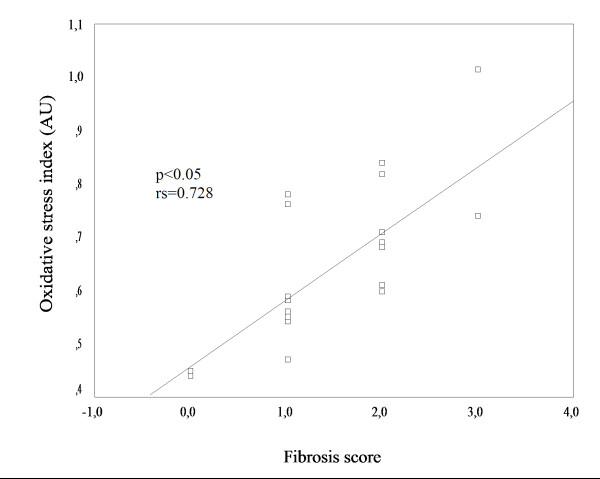
Correlation between oxidative stress index and the score of liver fibrosis among nonalcoholic steatohepatitis group. AU, arbitrary unit.